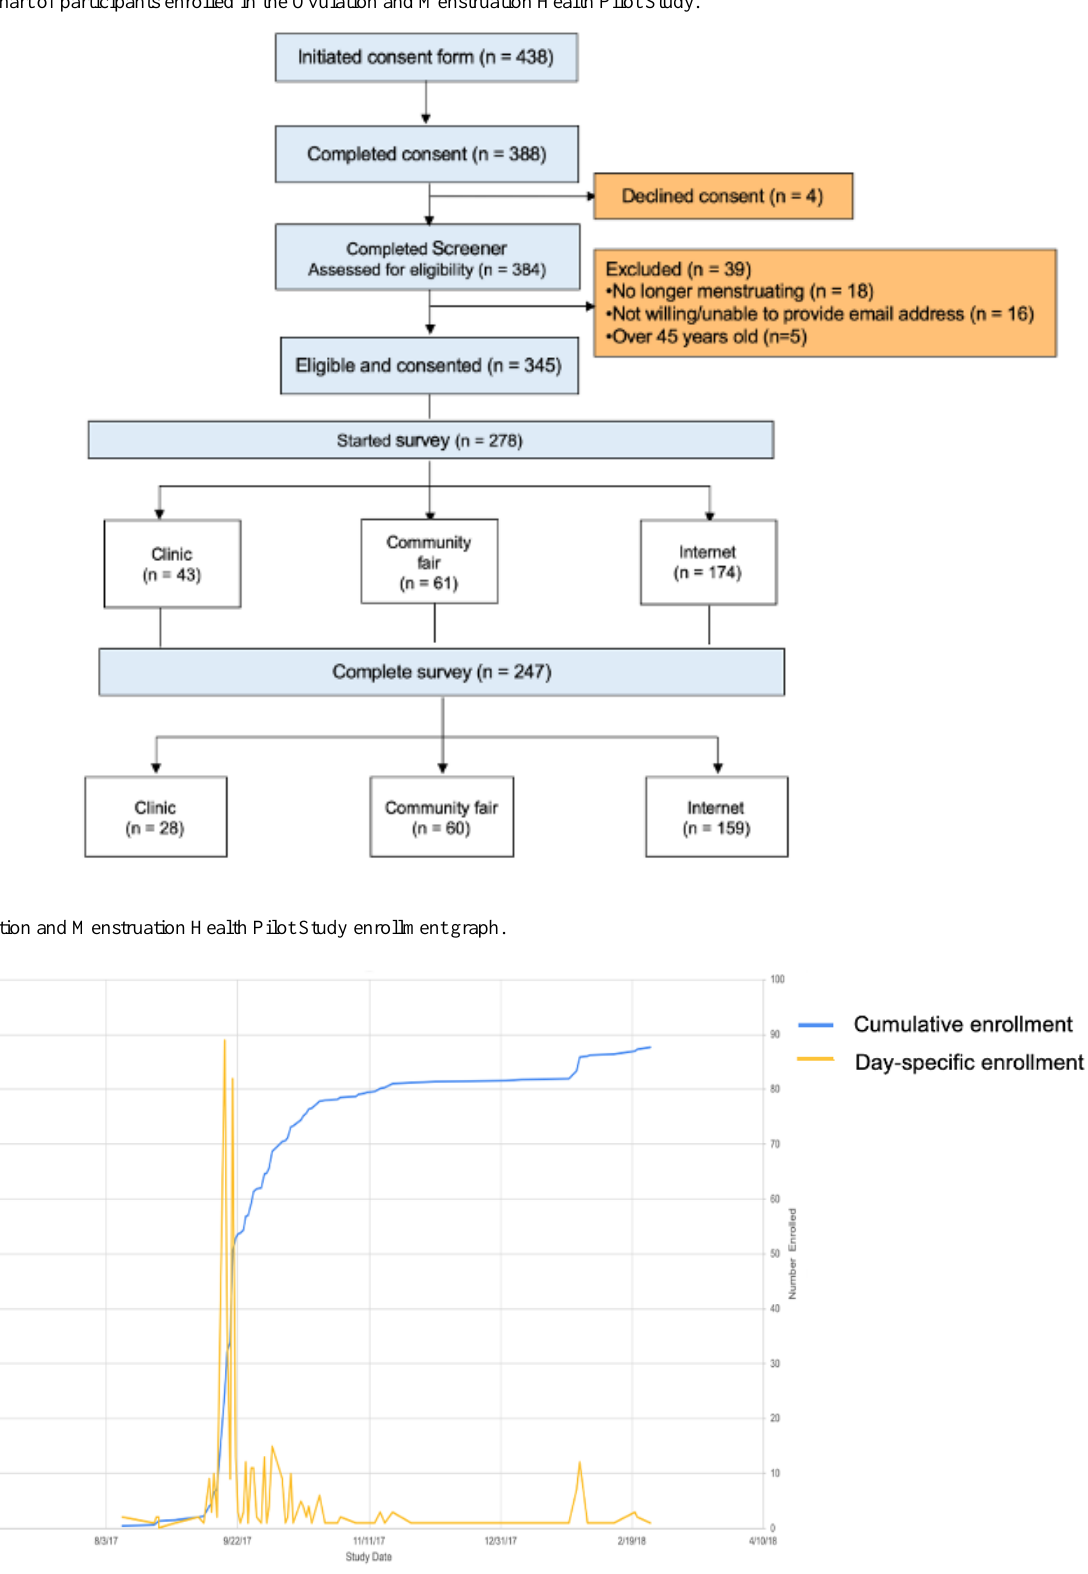
Figure 1. Flowchart of participants enrolled in the Ovulation and Menstruation Health Pilot Study.